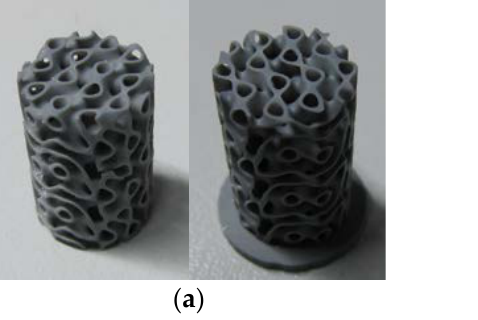
Figure 9. Uniaxial compression of a Si 3 N 4 -cylinder with SplitP TPMS structure: ( a ) manufactured specimen with and without loading plate; ( b ) specimen inside the uniaxial test setup.